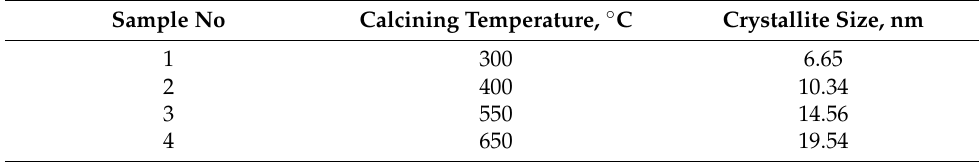
Table 1. Crystallite size of calcined powders, calculated by using Scherrer’s formula [26,27].